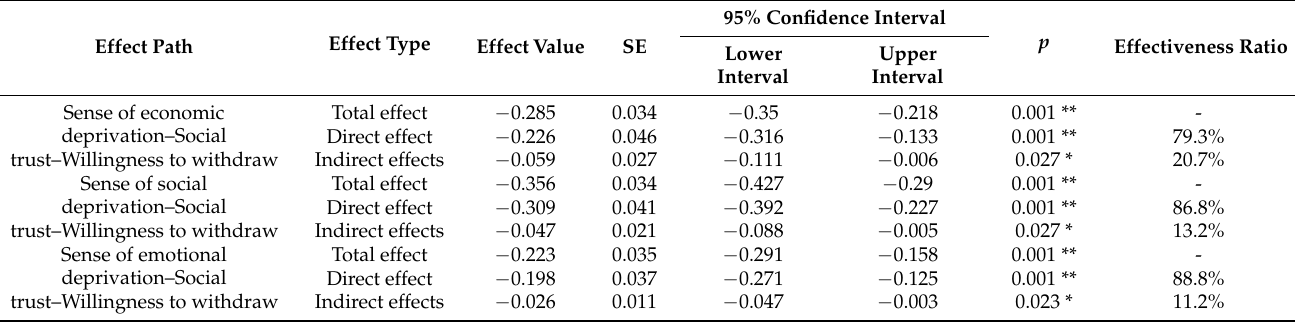
Table 8. Bootstrap method mediating effects test